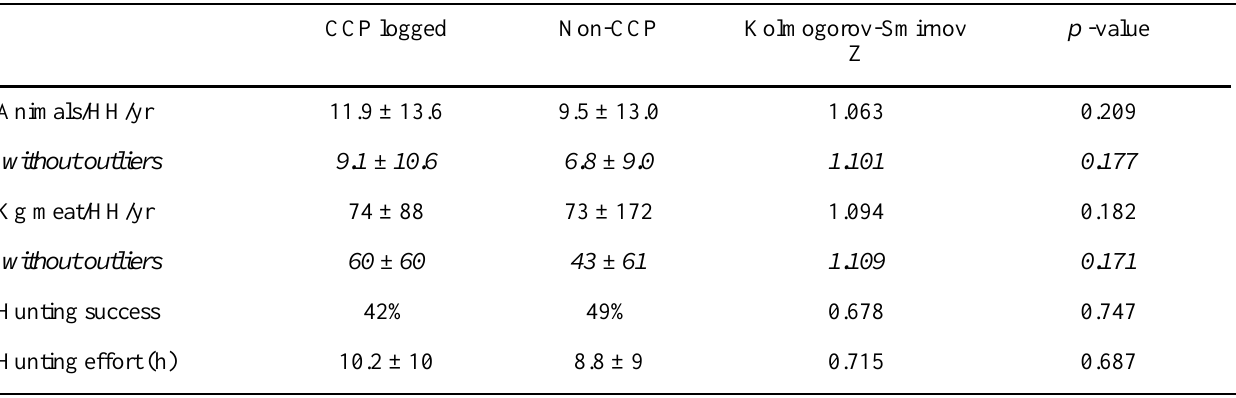
Table 4. Hunting rates in CCP-logged and non-CCP communities. HH = household; animals/yr and kg meat/yr are based on diary records (CCP logged: n = 22; non-CCP: n = 26). Hours hunt/animal and success rate (percentage of hunting trips in which at least one animal was caught) are based on bi-weekly questionnaires (CCP logged: respondents = 26, total number of surveys = 324; non-CCP: respondents = 30, total number of surveys =